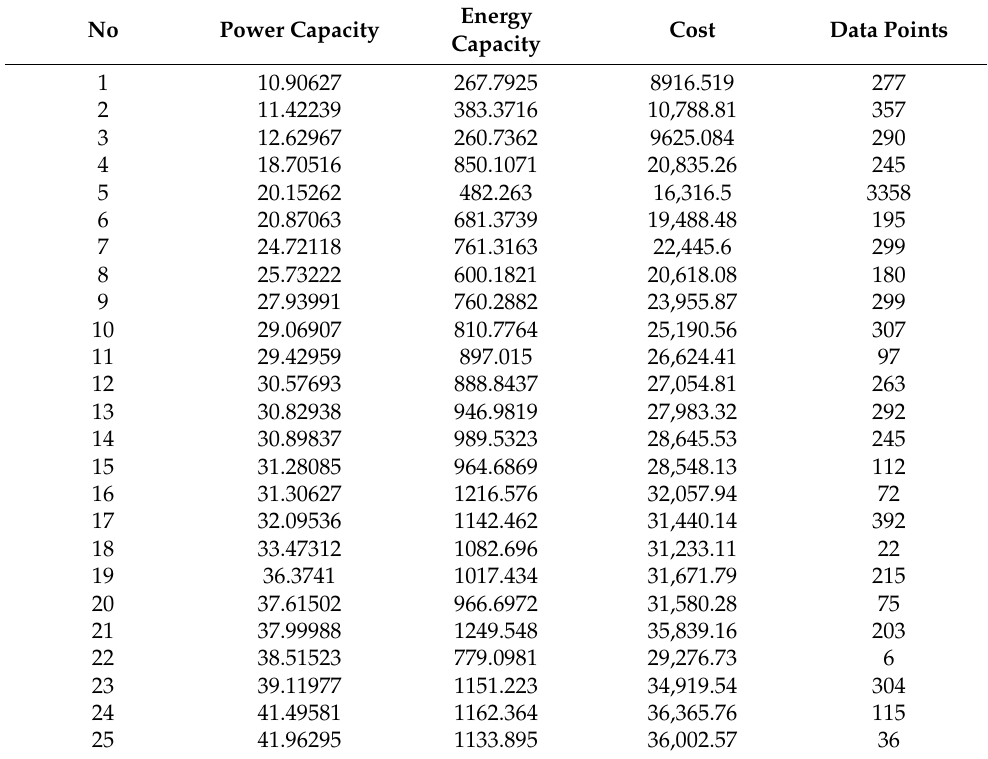
Table 3. Record of the simulation result in the case of 25